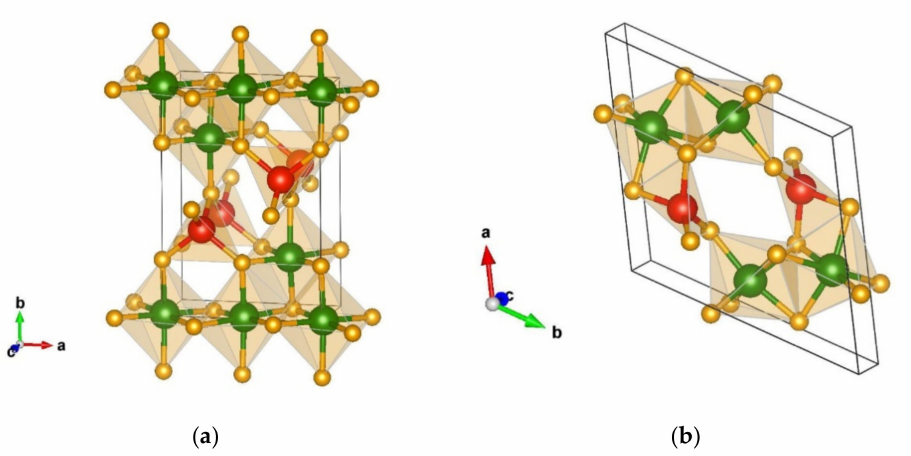
Figure 1. Visualization of favorable Cr 2 SiN 4 modifications: ( a ) α -Cr 2 SiN 4 -type in space group Pma2 (no. 28); ( b ) β -Cr 2 SiN 4 - type in space group P-1 (no. 2). Green, red, and yellow spheres denote Cr, Si, and N atoms,